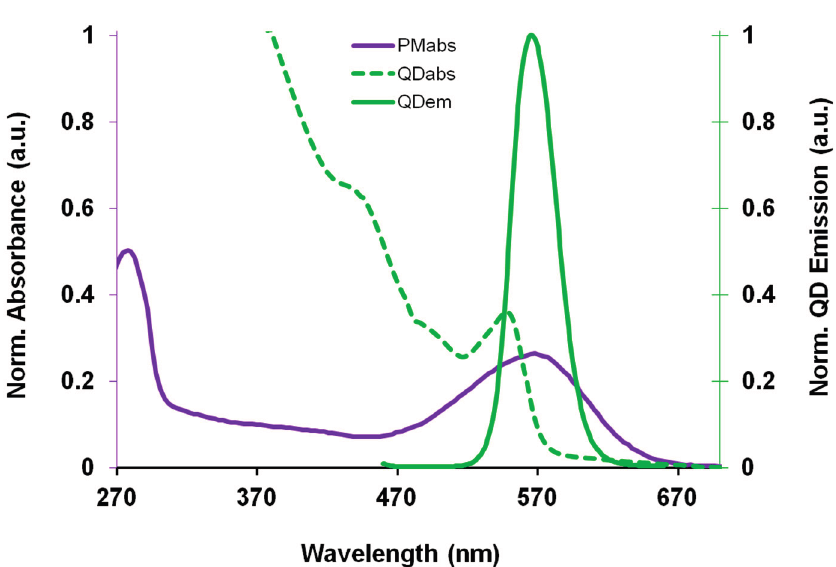
Figure 3. FRET coupling energy bands of bR (purple solid) and size-selected CdSe/ZnS QDs (green dashed), with overlapping QD emission (green